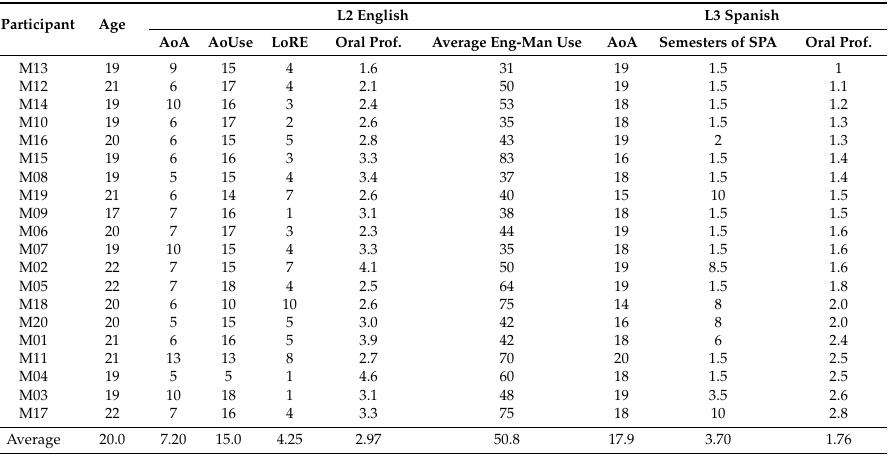
Table A1. L1 Mandarin–L2 English–L3 Spanish participant profiles, ordered by L3 Spanish oral proficiency ratings, from lowest to